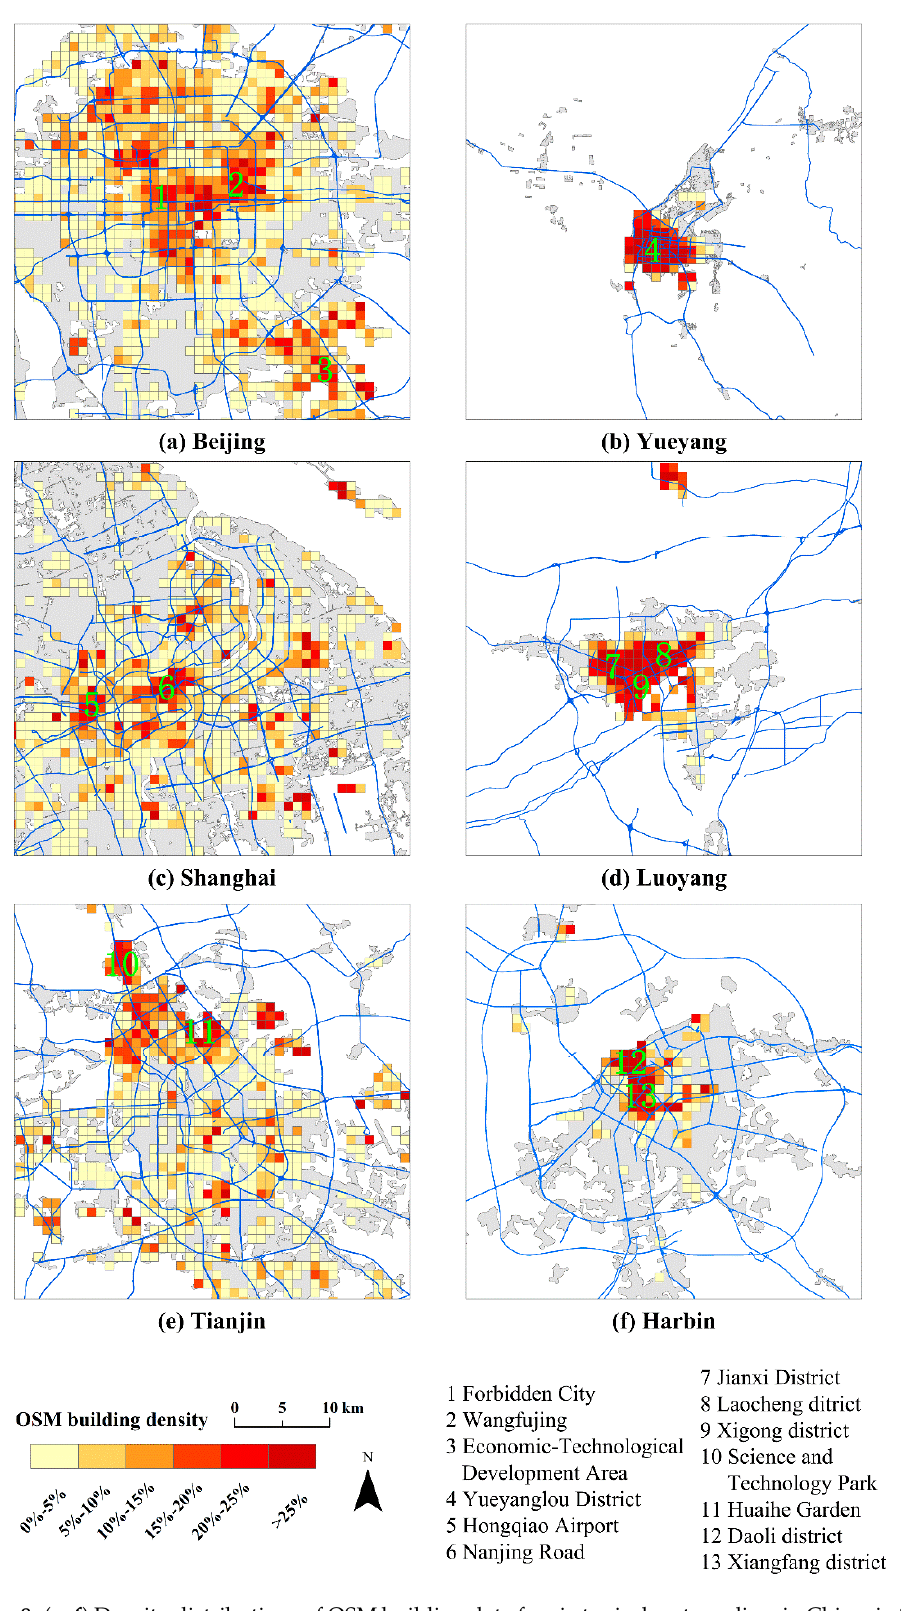
Figure 8. ( a – f ) Density distributions of OSM building data for six typical metropolises in China, in 2017.